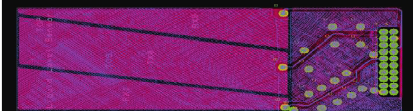
Figure 9: Sensor PCB.